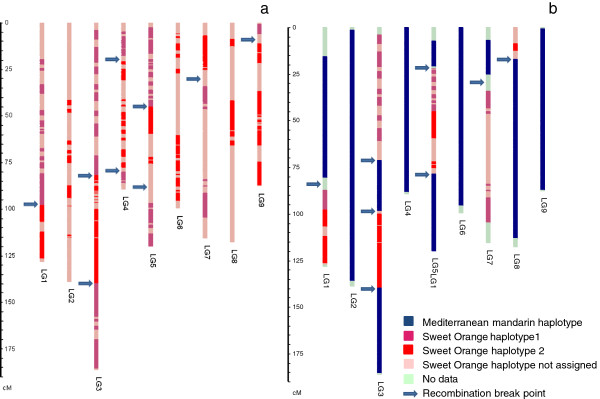
Haplotype constitution of the sweet orange gamete at the origin of Clementine (a) and of the haploid Clementine used to establish the reference whole citrus genome sequence (b).